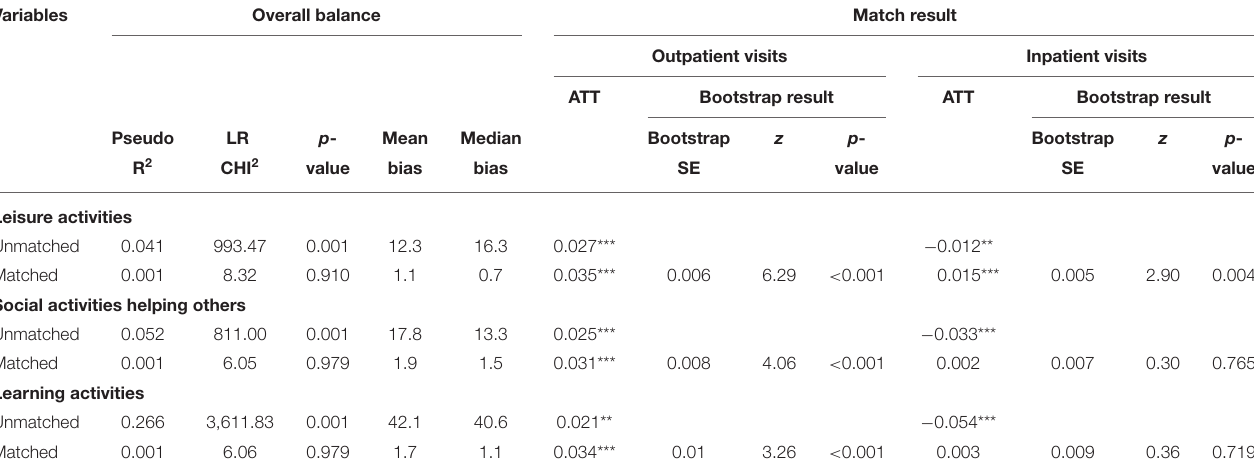
TABLE 3 | Overall balance t -test and propensity score matched results and effect of each type of social participation. Variables Overall